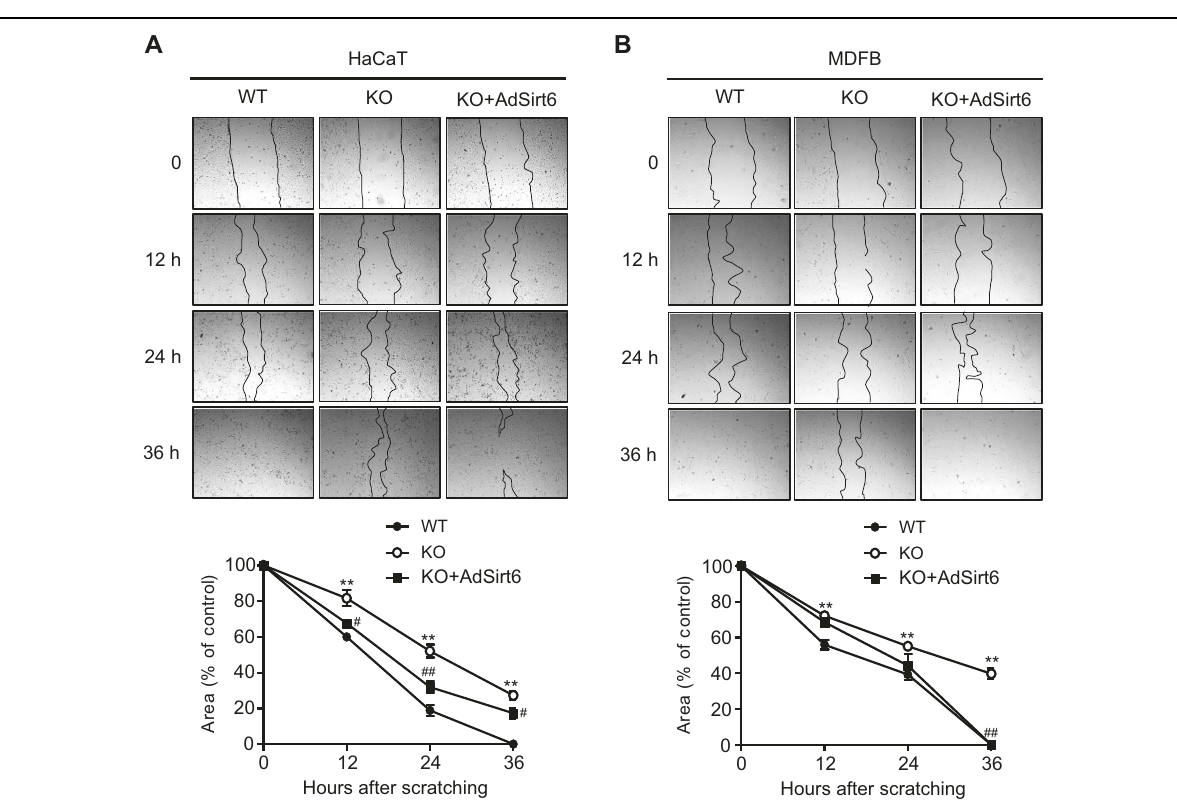
Fig. 6 Delayed migration of skin keratinocytes and fi broblasts in wound scratch assays. Bone marrow macrophages (BMMs, 2 × 10 6 ) isolated from WT or KO mice were treated with TNF- α (10 ng/ml), IL-1 β (10 ng/ml), and IL-6 (10 ng/ml) for 3 h, and then conditioned medium (CM) was harvested. Scratch wounds were made in monolayers of HaCaT ( a ) and MDFB cells ( b ). For rescue experiments, KO BMMs were transduced with AdSirt6. Representative images show the progression of wound closure at the indicated times. The scratch area is indicated by a dotted line. The rate of wound closure was calculated by measuring the scratch area under the same magni fi cation at different times. Values represent the mean ± SEM ( n = 8) ** p < 0.01 vs. WT; # p < 0.05; and ## p < 0.01 vs.